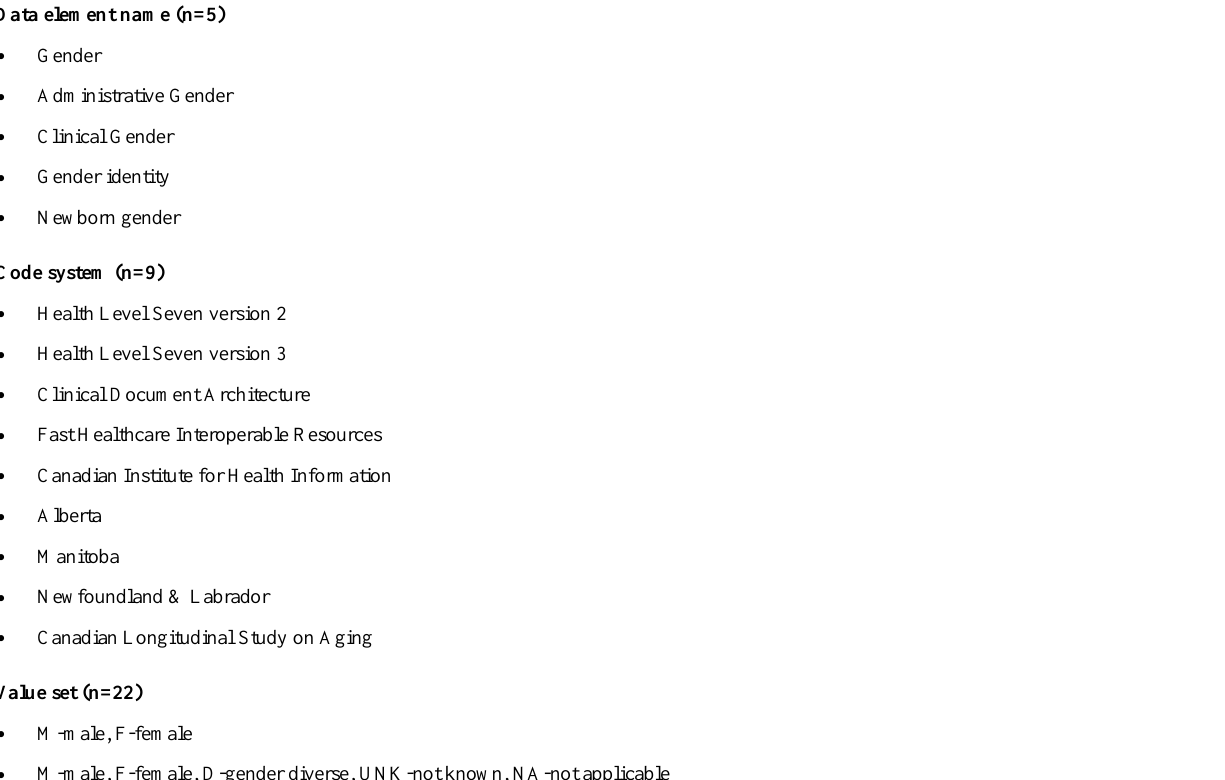
Textbox 2. Summary of definitions for gender in Canadian electronic health